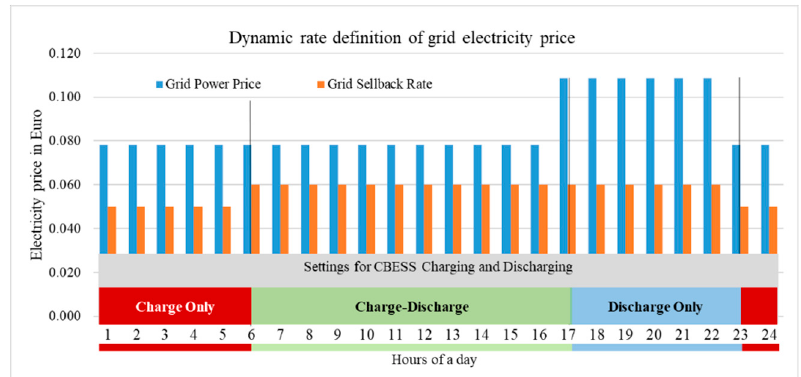
Figure 10. Dynamic rate definition of grid electricity price (power price and sellback rate) and conditions for CBESS dispatch.